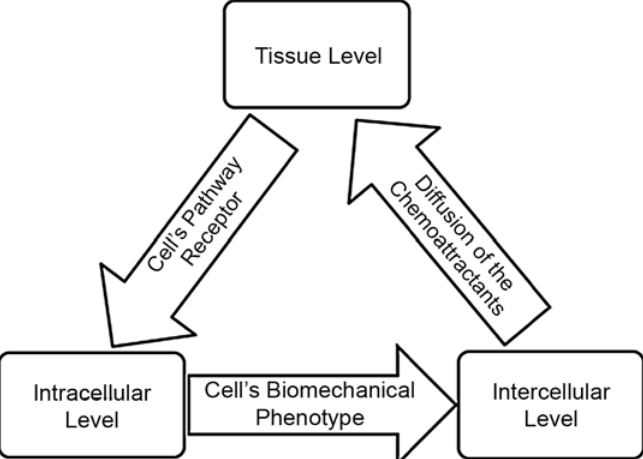
Fig 3. Schematic of the multi-scale modeling of OBs, OCs and MMs. Intracellular scale : describes the communication among myeloma cells, osteoclasts and osteoblasts and their ‘ phenotypic ’ switches. Intercellular scale : describes the dynamics of molecules in signaling pathways for each cell after receiving cytokine stimulation from other cells and the specific migration rules for cells. Tissue scale : describes the diffusion of drugs and